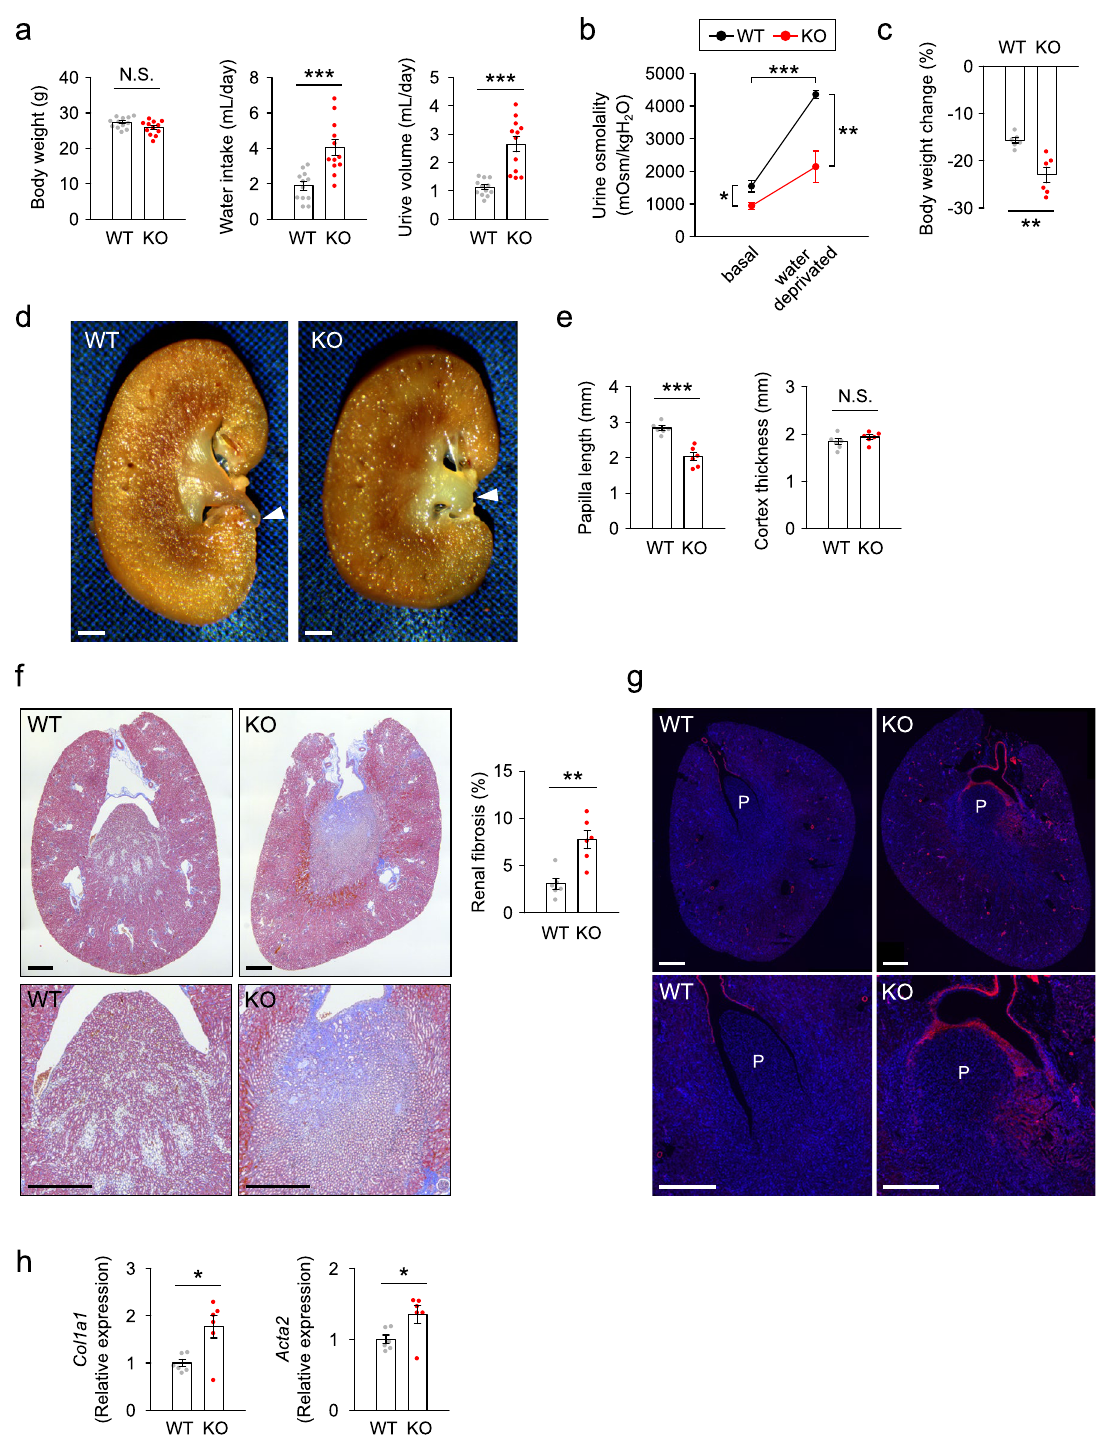
Figure 2. Distal tubule-specific Rac1-deficient mice in adulthood show impaired urine-concentrating ability with shortening and damage of renal papilla. ( a ) Body weight, water intake, and urine volume in WT and KO mice ( n = 12 per group). ( b ) Urine osmolality at baseline and after water deprivation ( n = 6 per group). ( c ) Body weight change after the water deprivation ( n = 6 per group). ( d ) Representative photomicrographs of coronal sections of the kidneys. Arrowheads indicate tips of papilla. The papilla protruded out of the renal hilus in WT mice, but it was clearly shortened in KO mice. ( e ) Quantification of the papilla length and cortex thickness. ( f ) Representative photomicrographs of Masson’s trichrome-stained transverse sections of the kidneys (upper: whole image, lower: enlarged image around papilla) and quantitation of renal fibrosis ( n = 6 per group). ( g ) Immunofluorescent staining of α-SMA (red) in transverse section of the kidneys. Nuclei were counterstained with DAPI (blue). P: papilla. ( h ) Quantitative analysis of renal expression of fibrosis-associated genes ( n = 6 per group). The expression was normalized to a reference gene ( Rps29 ) and reported relative to the WT group. Data are expressed as mean ± SEM. Statistical significance was analyzed by unpaired t test, except in ( b ), and two-way repeated-measures ANOVA with Holm-Sidak’s post hoc test in ( b ). * P < 0.05; ** P < 0.01; *** P < 0.001. N.S.: not significant. Scale bars, 1 mm ( d ); 500 μm ( f , g